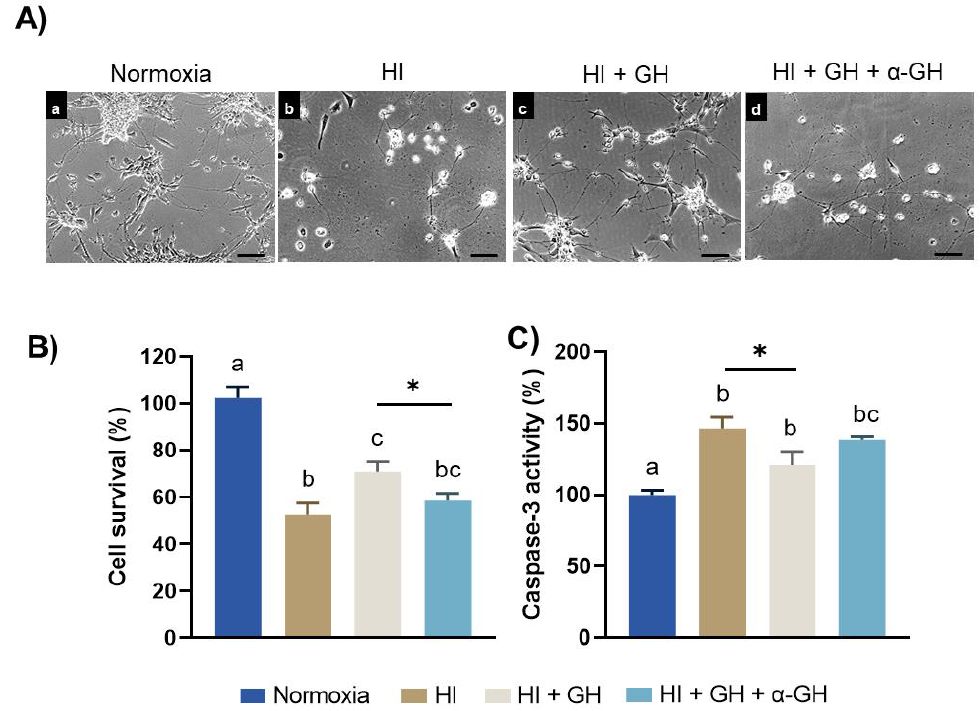
Figure 1. Effects of growth hormone (GH) upon cell survival and apoptosis in pallial primary cell cultures after a hypoxic–ischemic (HI) injury. ( A ) Representative phase–contrast images of primary cell cultures obtained from embryonic chicken pallium exposed to either: (a) normoxic, (b) HI, (c) HI + 10 nM GH, or (d) HI + 10 nM GH + 1:20 dilution of specific anti-cGH antibody (α-GH), incuba- tion conditions. Scale bar: 50 µm. ( B ) Cell survival was evaluated by MTT assay, and ( C ) Caspase-3 activity was determined with a colorimetric assay in primary pallial cultures exposed to either normoxia, HI, HI + GH, and HI + GH + α-GH incubation conditions. Bars represent mean ± SEM (from 3 independent experiments in duplicate; n = 6 cultures per group). Groups with different let- ters are significantly different by one-way ANOVA with Tukey’s post hoc test ( p < 0.05). An un- paired Student’s t test was used to compare HI versus HI + GH groups (panel C ), and the asterisks (*) indicate a significant difference (* p < 0.05).